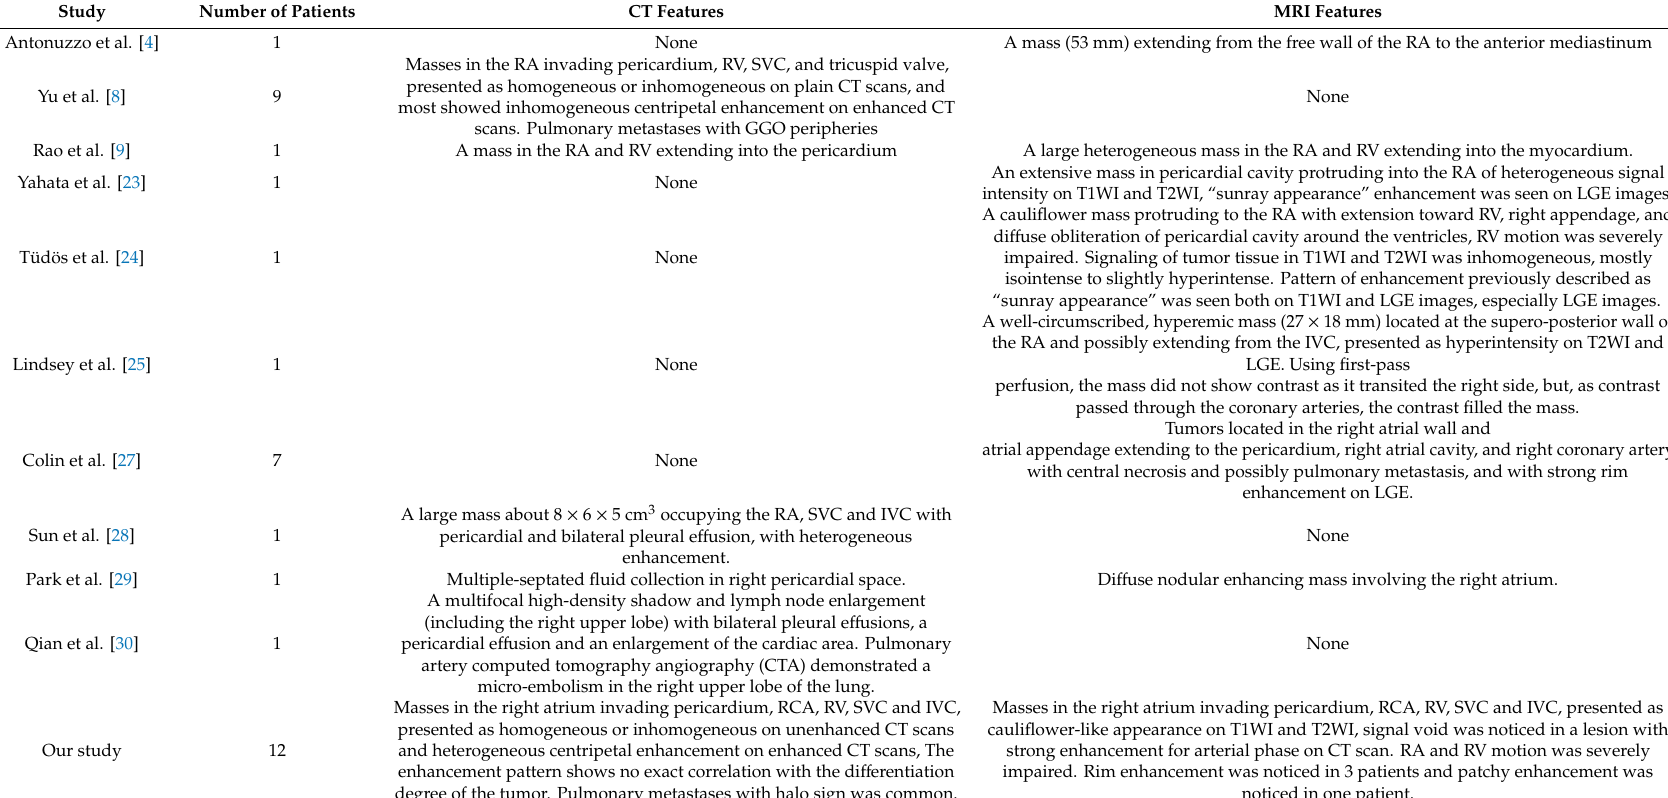
Table 4. Comparison among studies on imaging features of primary cardiac